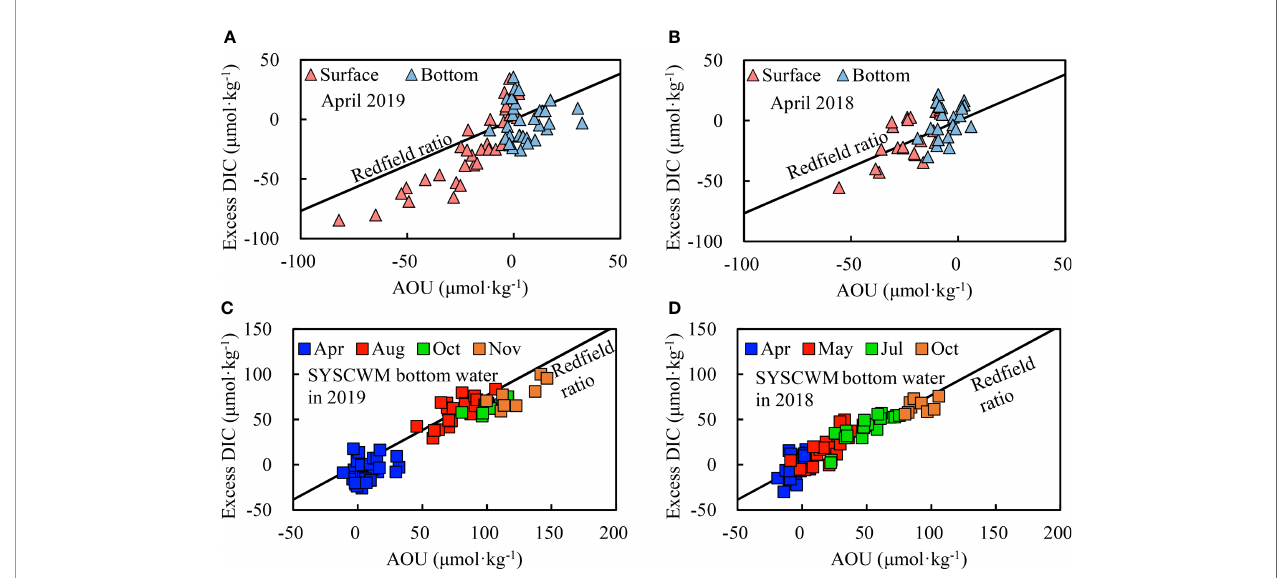
FIGURE 5 | Relationship between excess DIC and AOU in the SYS in spring (A, B) and in the SYSCWM from spring to autumn (C, D) . The relevant Red fi eld ratio is traditionally estimated as excess DIC : AOU = 106:138.